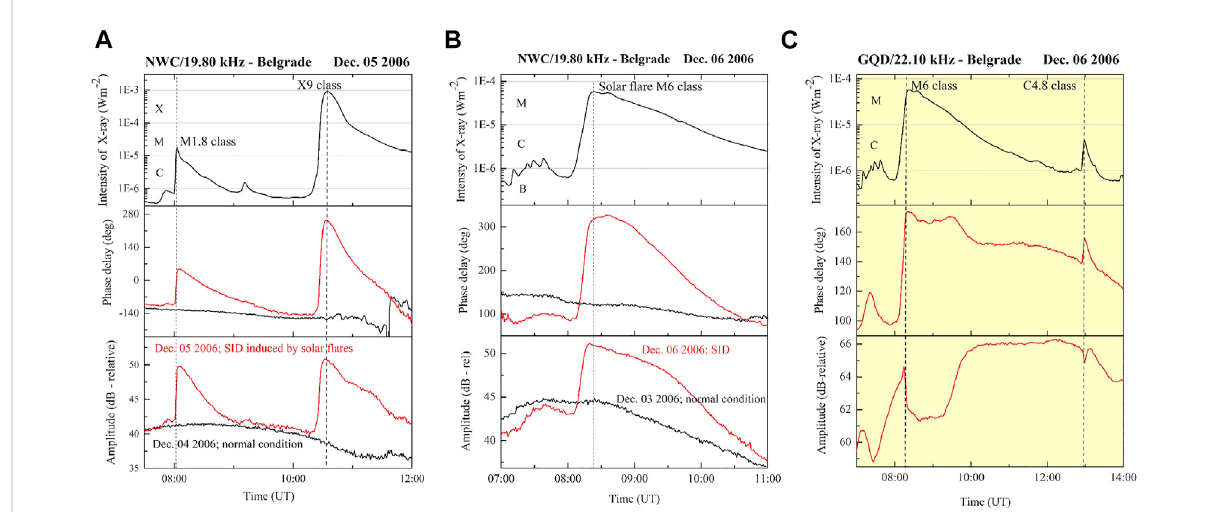
FIGURE 10 (A,B) VariationofX-rayirradiance(panel1),phase(panel2)andamplitude(panel3)onNWC/19.80 kHzradiosignalrecordedatBelgradeagainst UT on normal day, 03 and 04 and disturbed days, 05 and 06 December 2006, respectively. (C) Variation of X-ray irradiance (panel 1), phase (panel 2) and amplitude (panel 3) on GQD/22.10 kHz data recorded at Belgrade against UT on disturbed day 06 December